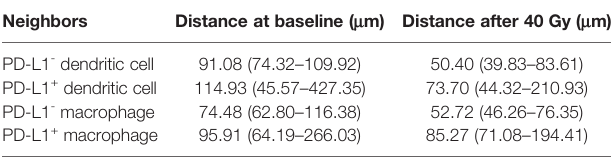
TABLE 1 | Nearest distance from tumor cells to